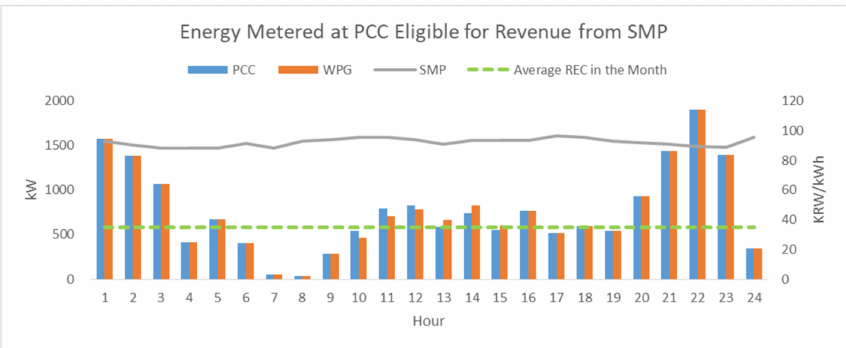
Figure 4. Intraday control status of the output compared with patterns of the